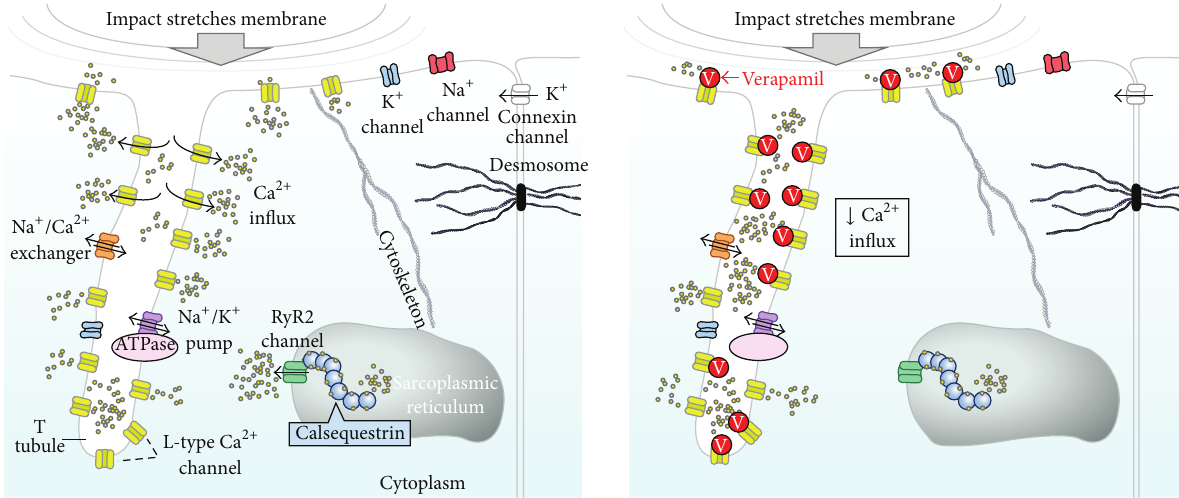
Figure 1: Impact of the chest wall marked increases left ventricular intracavitary pressure which in turn amplifies left ventricular wall strain and myocyte membrane stretch. This cell membrane deformation may activate stretch activated ion channels, which may in part cause the ventricular fibrillation in commotio cordis. In the left panel, a placebo animal, there is an increased influx of calcium due to stretch activation of the I Ca , L channel. If the I Ca , L channel is involved in commotio cordis, blockade of the channel (right panel) should reduce the ventricular fibrillation seen in our